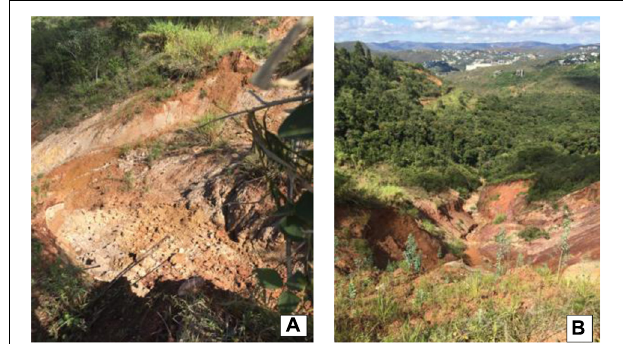
FIGURE 14 | Degradation in the head and sides of the V1 gullies in 2019. (A) Loose soil at the headland and slope of gully V1; (B) view of the headland of gully V1, still showing the valley’s floor protected by native